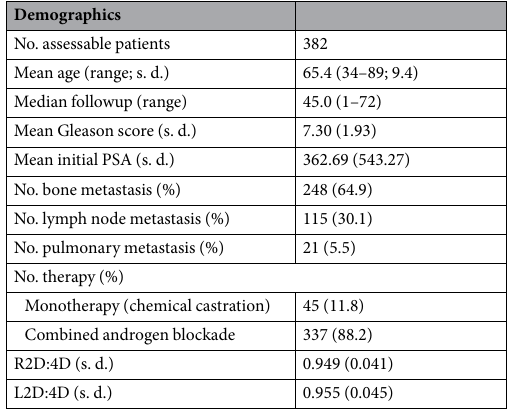
Table 1. Patient